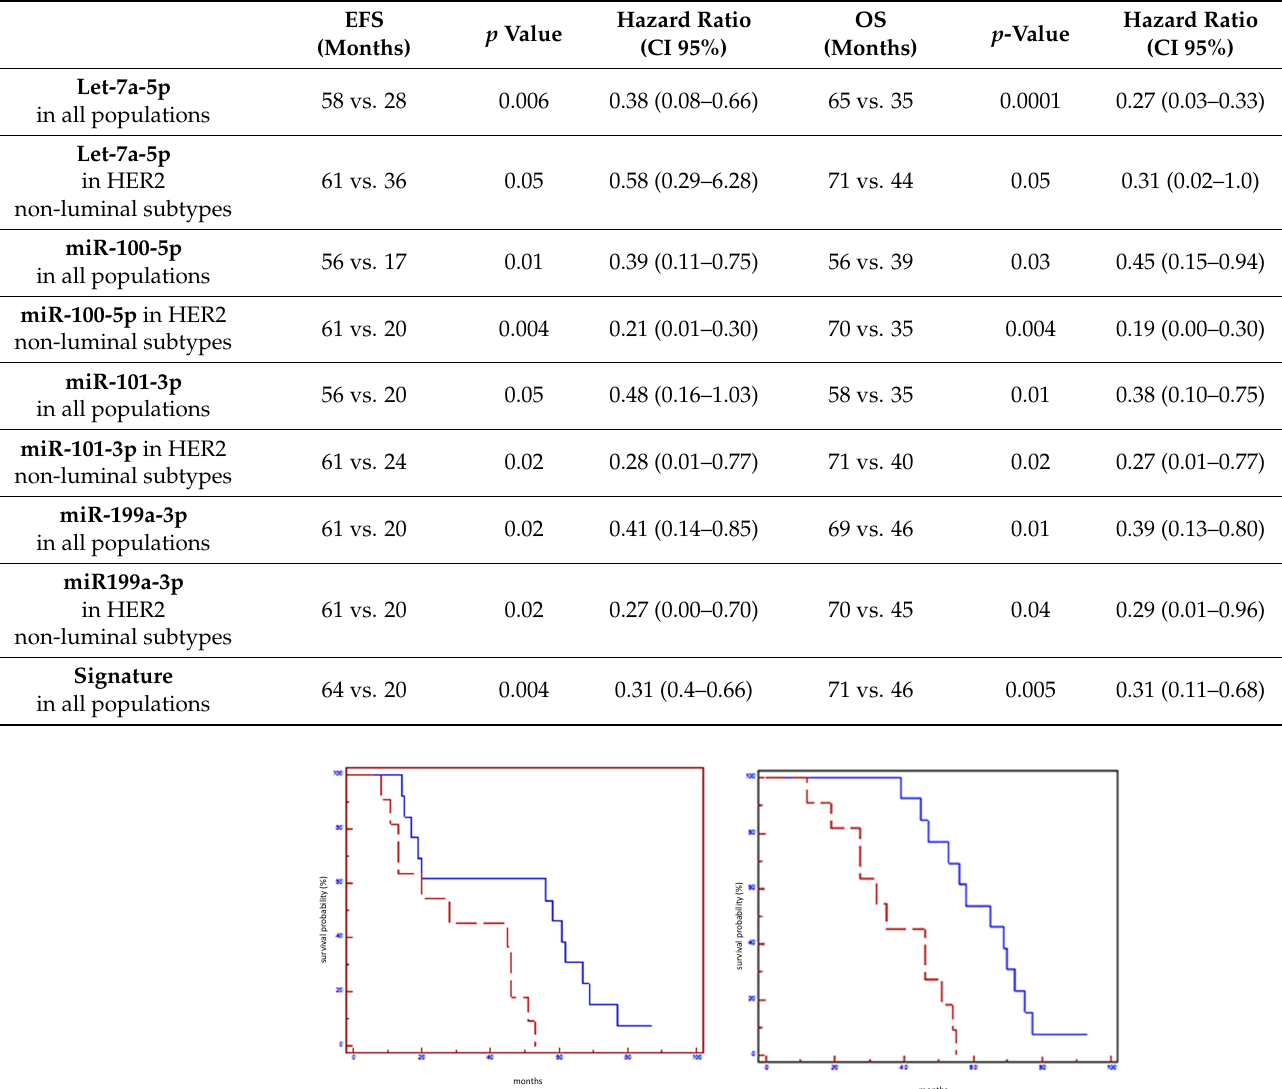
Table 5. Prognostic impact of miRNA expression profile on EFS and OS in all populations and in HER2 non-luminal subtypes.